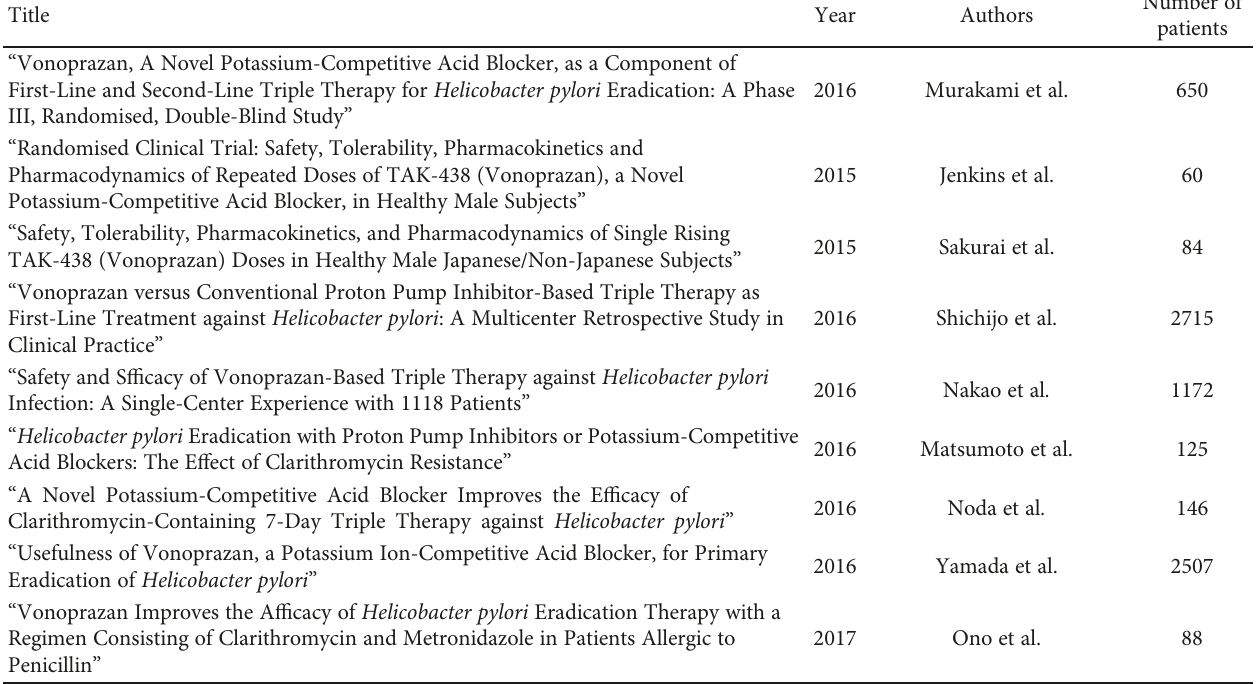
Table 1: Distribution of included patients in vonoprazan-based therapy of H. pylori in recent years.